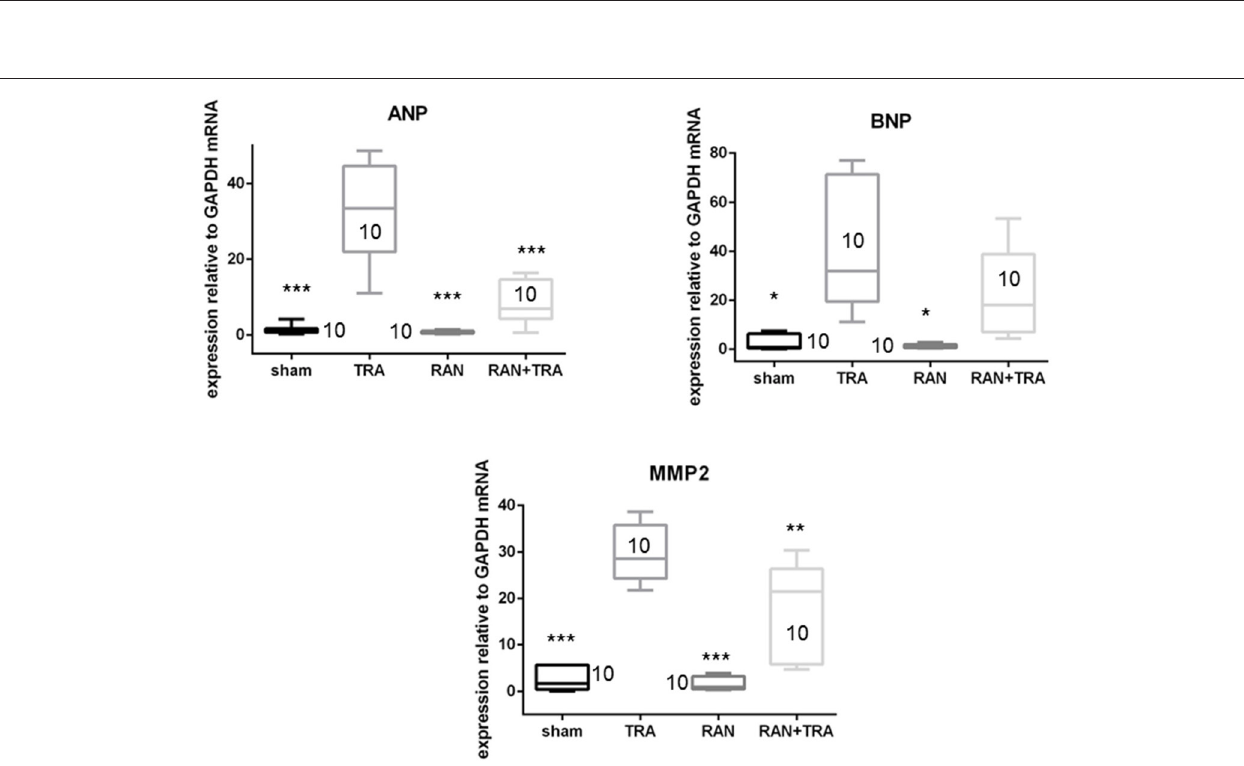
FIGURE 2 | Effects of ranolazine on cardiac fetal gene reprogramming. ANP, BNP, and MMP2 mRNA expressions induced by trastuzumab were reduced in mice pretreated with ranolazine (* p < 0.05 vs. TRA; ** p < 0.005; *** p < 0.0005).